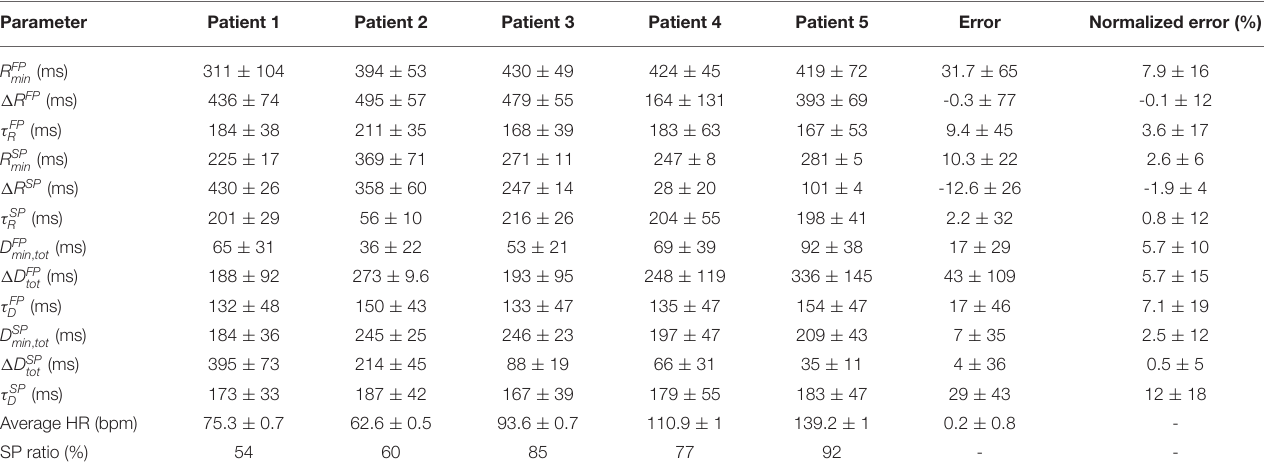
standard deviation of 200 optimizations for the five simulated data sets, together with the mean error ±